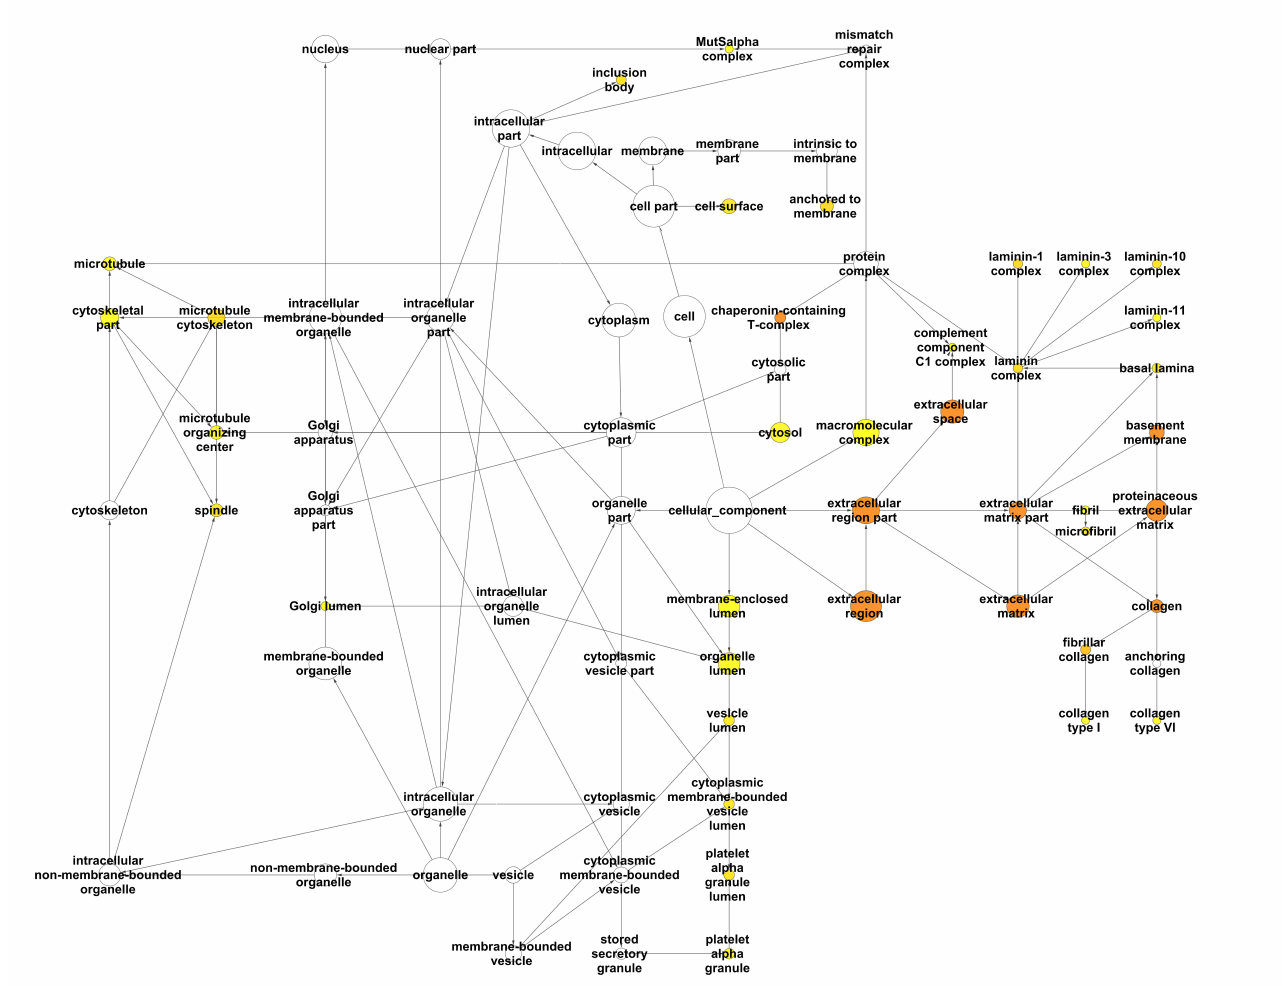
Figure 4. Analysis of the LOX family interactome with BiNGO for the GO term “Cellular Component”. For each GO term category, BiNGO provides a layout of interconnected and colored circles corresponding to each annotation. The circle diameter indicates the number of proteins annotated by a GO term. The yellow to orange color gradient is correlated to the p -value ( p < 0.01), the more significant terms being colored